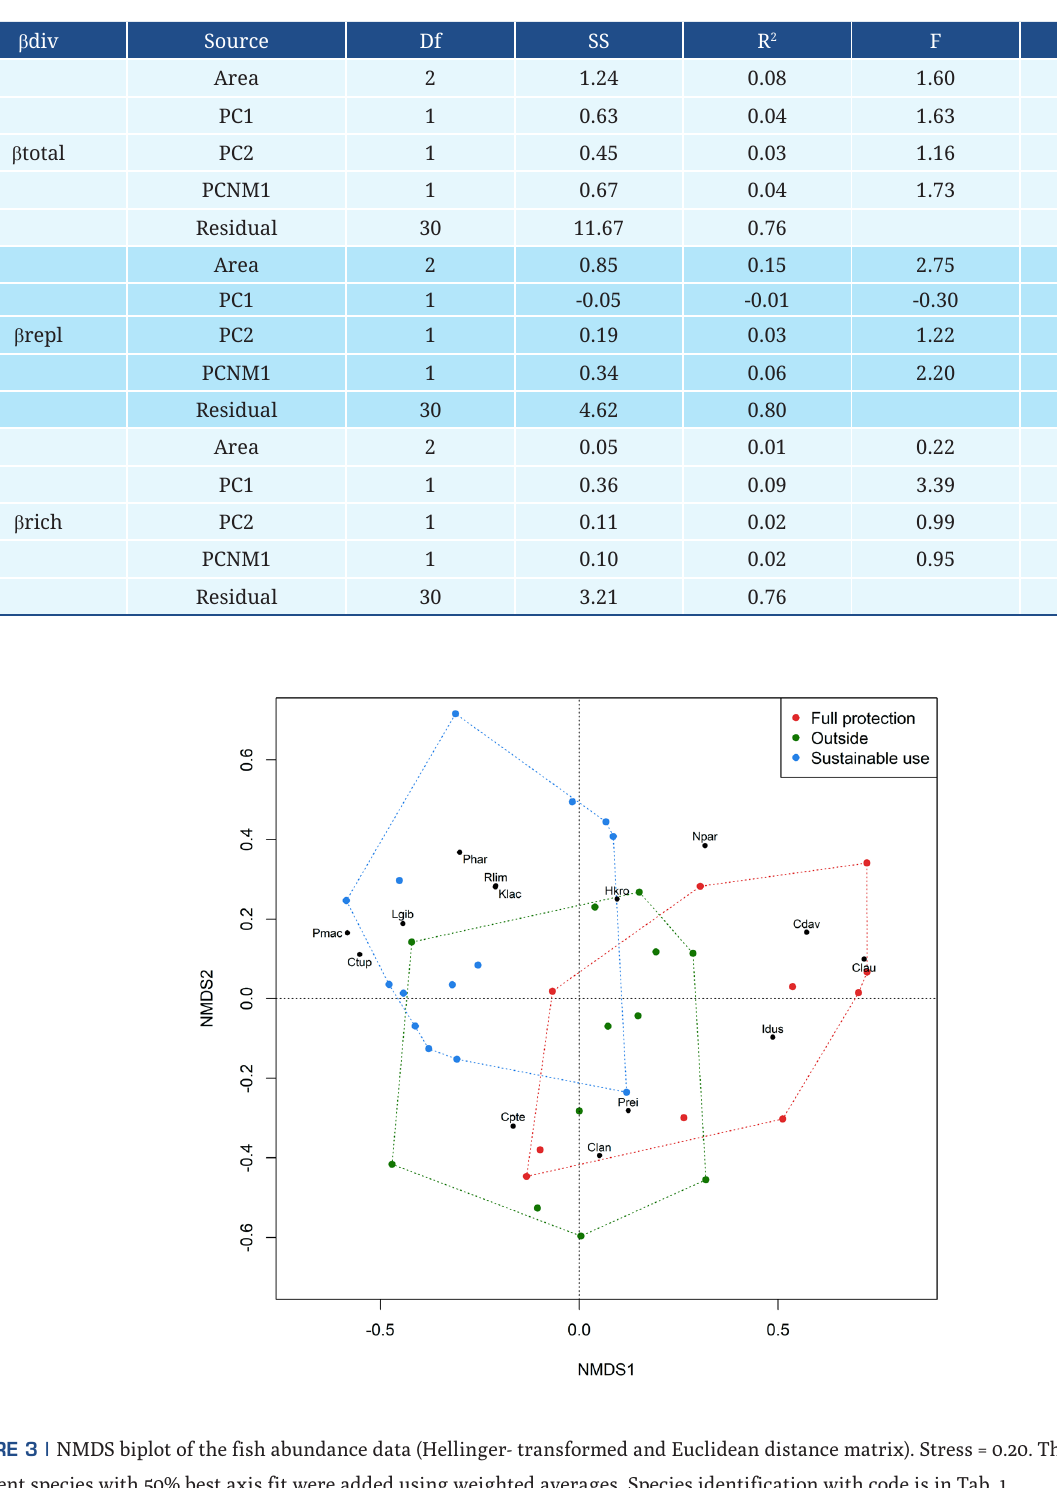
TABLE 2 | Beta diversity PERMANOVA table. Beta diversity ( β div): Beta total ( β total), beta replacement ( β repl), and beta richness difference ( β rich). Source: Area type (Area), environmental principal components (PC1 and PC2), spatial variable (PCNM1). Degrees of freedom (Df), sums of square (SS), R square (R 2 ), F statistics (F), and p-value (P). *Significative